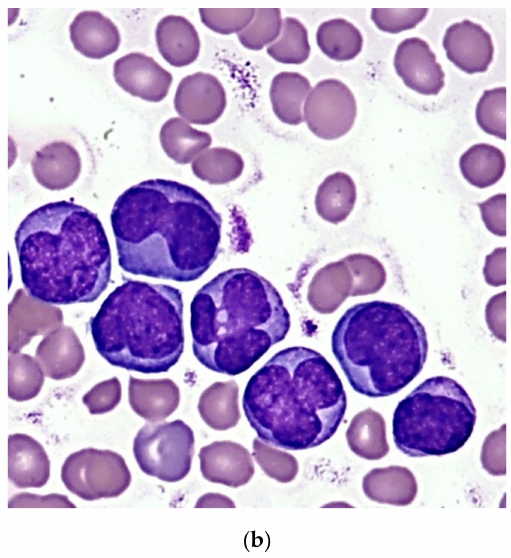
Figure 3. ( a ) Morphology of pathologic cells in the bone marrow smear in case 1. ( b ) Morphology of pathologic cells in the bone marrow smear in case